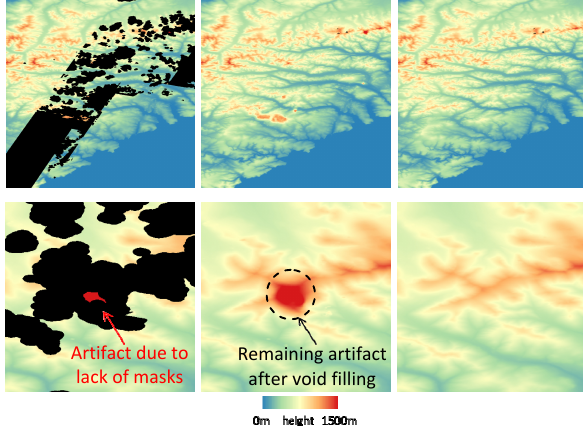
Figure 7. Comparison of AW3D30 DSMs for tile N61E161. Left to right: the original, the void-filled without the filtering, and the one with the filtering. Top: whole tile areas, Bottom: Zoom in an artifact.